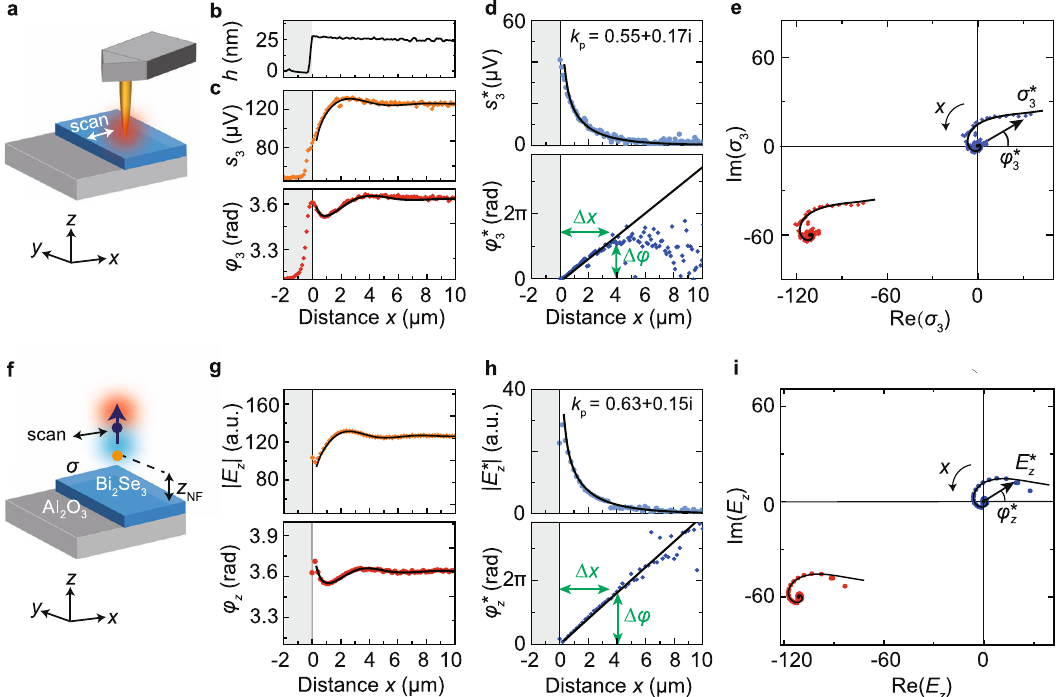
Fig. 2 Complex-valued analysis of THz near- fi eld line pro fi les of a 25-nm-thick Bi 2 Se 3 fi lm. a Sketch of the s-SNOM experiment. b Topography line pro fi le, showing the height h as measured by AFM. c Experimental s-SNOM amplitude and phase line pro fi les recorded at 2.52 THz. d Amplitude and phase line pro fi les obtained from the data shown in panel c after subtraction of the complex-valued signal offset C at large distances x . e Representation of near- fi eld line pro fi les in the complex plane. Data corresponding to panel c are shown in red color, data corresponding to panel d are shown in blue color. c – e The ffiffiffiffiffi p þ C , where C is a constant complex- black solid lines show the fi tting of the experimental data by a radially and exponentially decaying wave, Ae i 2 k p x = 2 x valued offset. f Simulation of s-SNOM line pro fi les: A vertically orientated dipole source (mimicking the tip) is located 1.5 μ m above a sheet of conductivity σ (blue, mimicking the Bi fi eld E z = 200 nm above the conductivity sheet is calculated and 2 Se 3 layer) on Al 2 O 3 . The electric z below the dipole at height NF plotted as function of the distance x between the dipole and the sheet edge. g – i Simulated amplitude and phase line pro fi les analogous to panels c – e . The = 0.55 + 0.17 i μ m − 1 . For better comparison between the experimental and simulation results, the offset C in conductivity was obtained from Eq. (2) with k p the simulations (red data) was replaced by the experimental offset and the phases in panels d and h were set to zero a x = μ